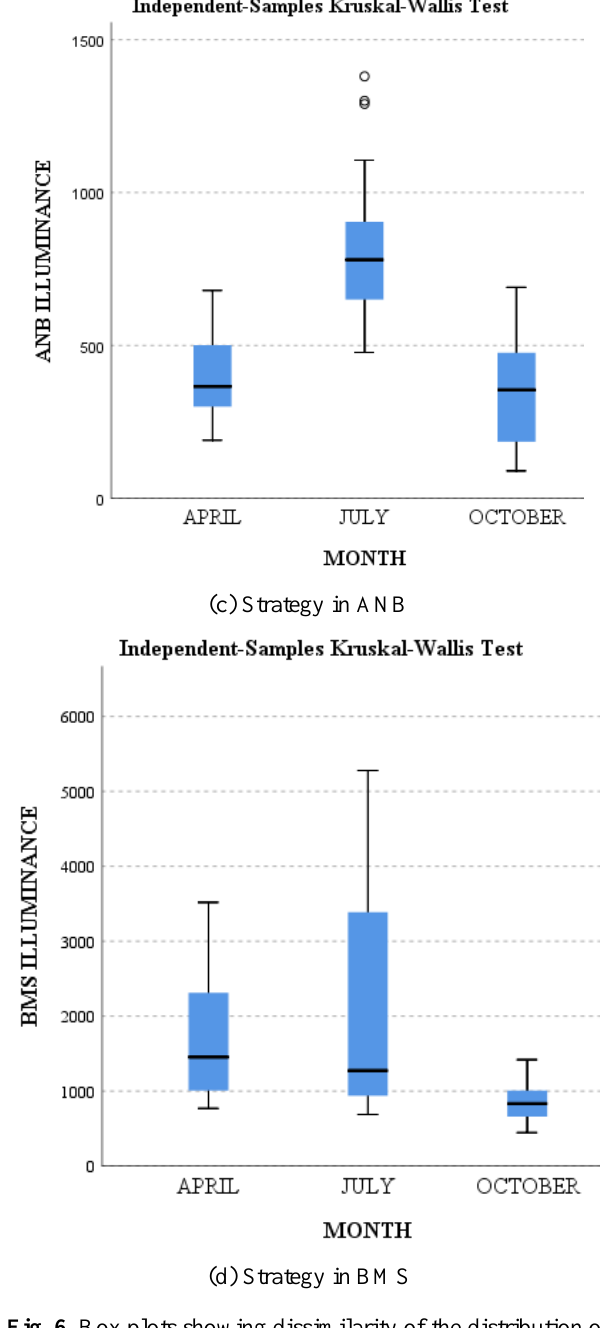
Fig. 6. Box plots showing dissimilarity of the distribution of the monthly illuminance in